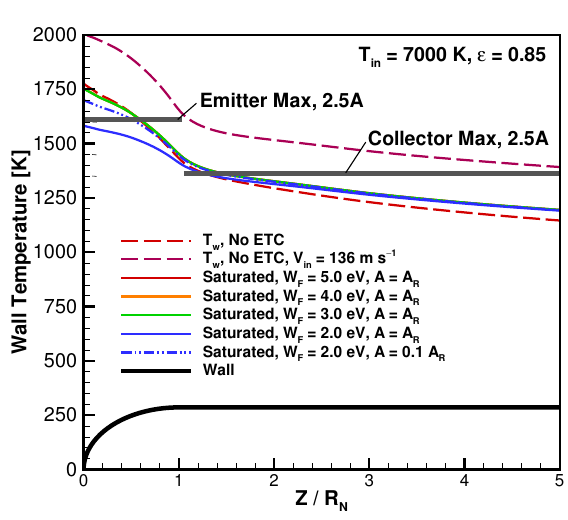
Figure 12. ETC effect on surface